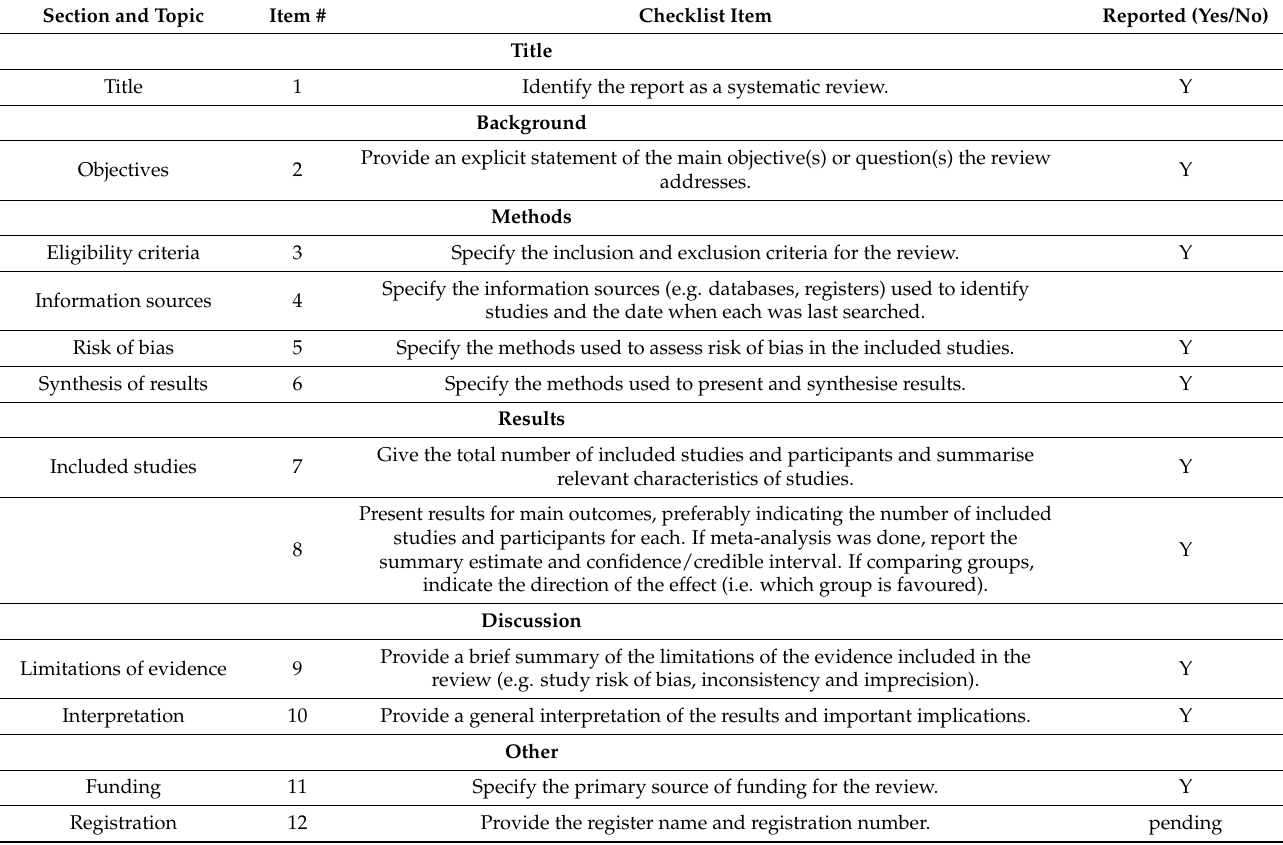
Table 1. PRISMA Abstract Checklist: http://www.prisma-statement.org/ (accessed on 13 June 2021) [3]. Section and